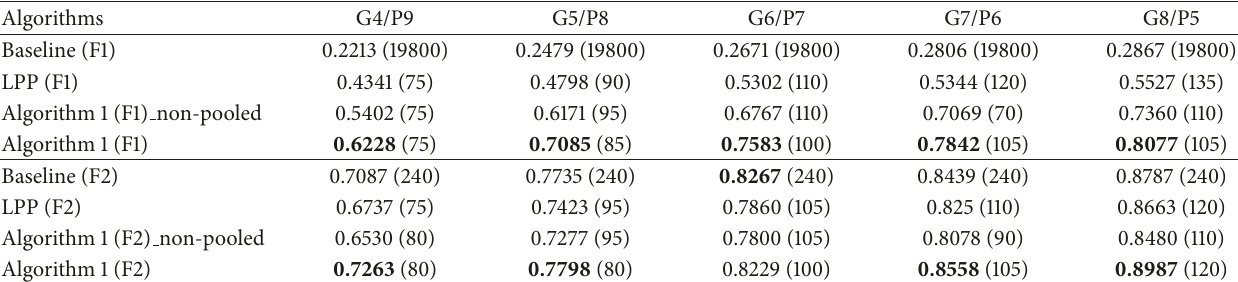
Algorithm 1 over the original “F ∗ ”